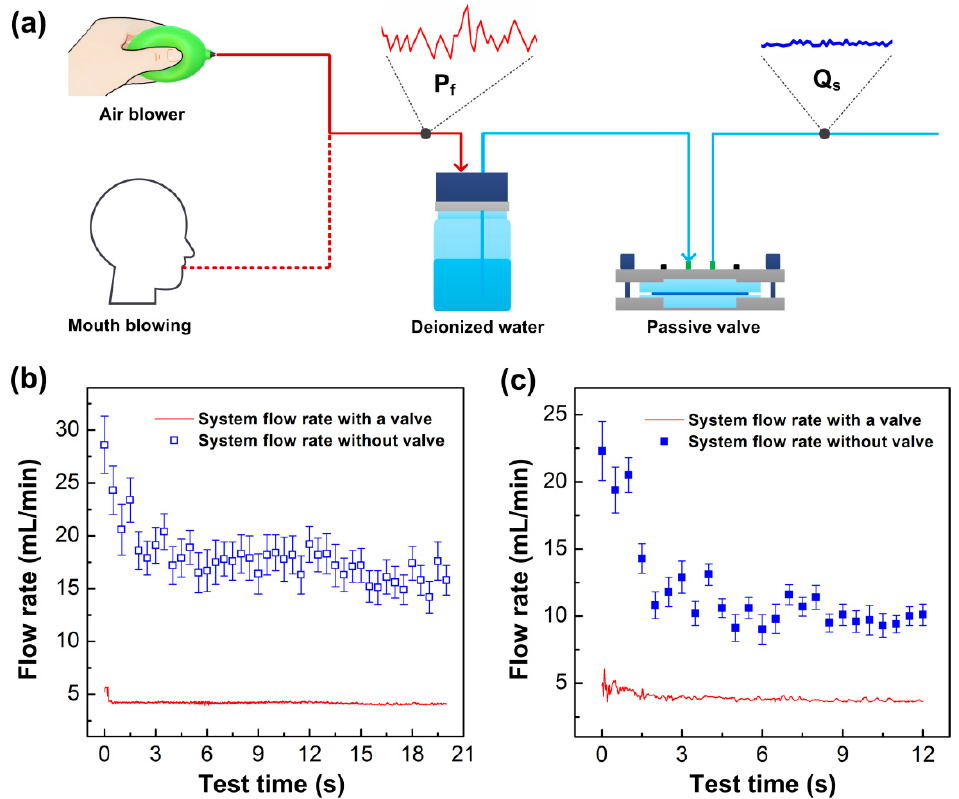
Figure 7. Application of the microfluidic passive valve for a stable flow in a low-cost portable gas-driven flow system. ( a ) Schematic diagram of the gas-driven flow system. Unstable pressure P f was produced by an air blower and by human mouth to drive liquid in the system, and stable flow rate Q s was achieved in the system. ( b ) Flow rate of the system operated by an air blower. ( c ) Flow rate of the system operated by mouth blown air.